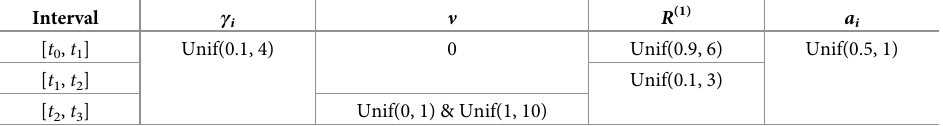
gence of the epidemic in MSM hosts and t 3 is the time of the most recent sampled sequence. Interval γ i ν R (1) a i [ t 0 , t 1 ] Unif(0.1, 4) 0 Unif(0.9, 6) [ t 2 , t 3 ] Unif(0, 1) & Unif(1,